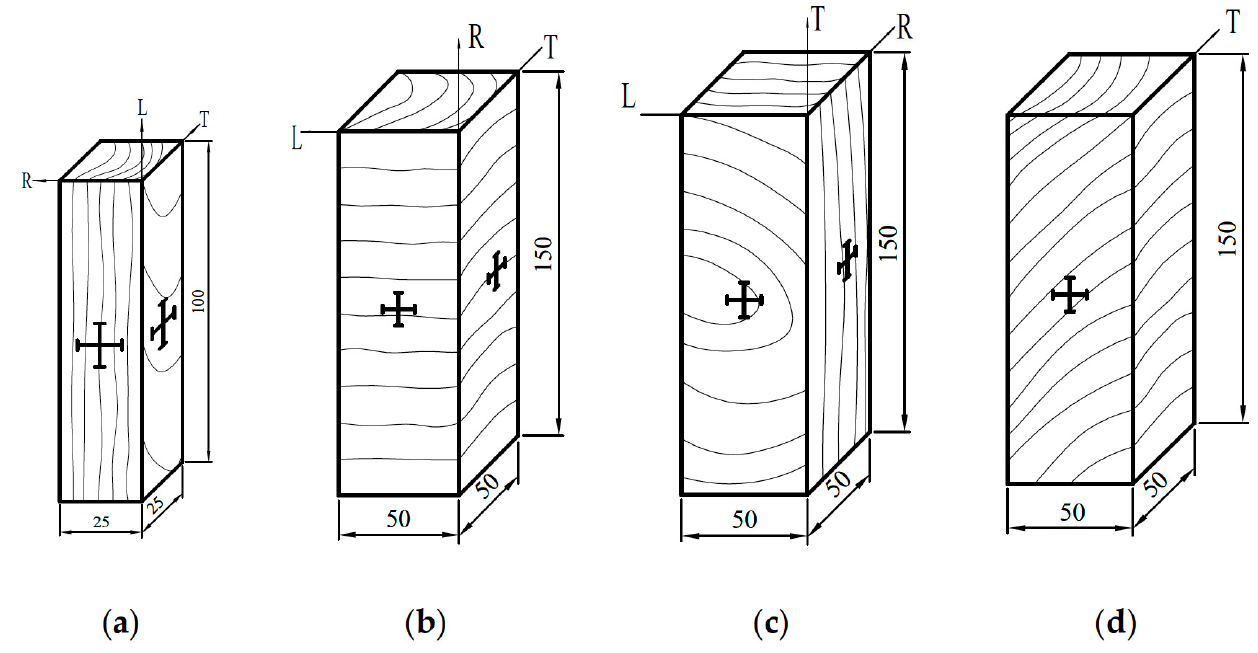
Figure 7. Schematic diagrams of rectangular wooden compression specimens cut at various angles to the grain of the wood. ( a ) Parallel to the grain. ( b ) Perpendicular to the grain radially. ( c ) Perpen- dicular to the grain tangentially. ( d ) at 45 ˚ to the grain. The ‘+’ signs indicate the position of strain gauges. From [84]. R means radial, L means length, T means tangential.